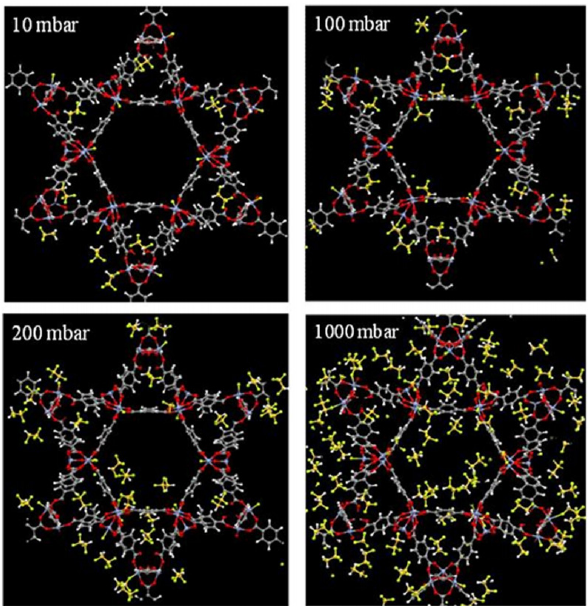
Figure 4. Molecular simulation snapshots showing increasing analyte concentrations within a MOF, revealing both adsorption and guest capture interactions [22].